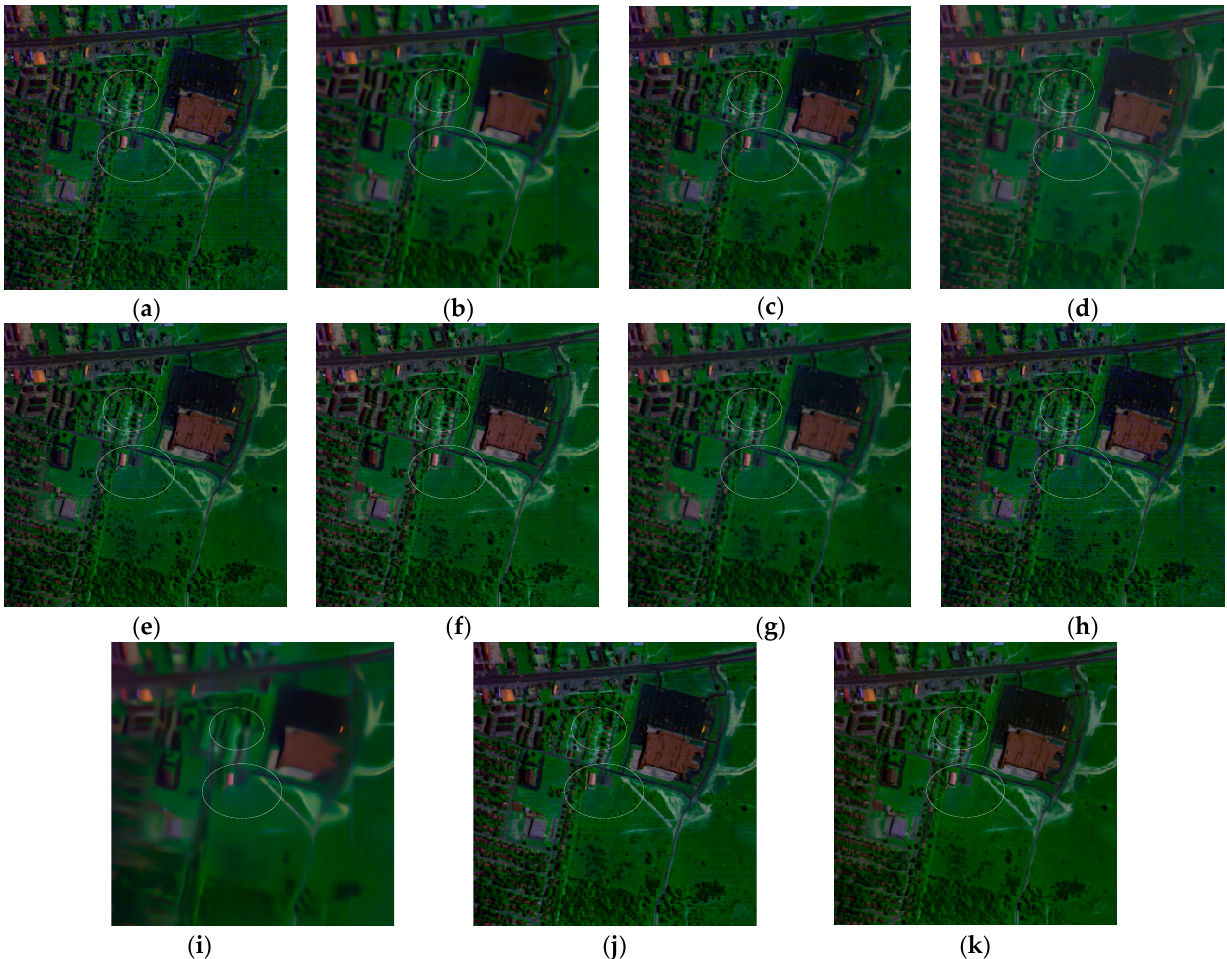
Figure 11. Restored results of the Urban image: ( a ) original pseudo-color image; ( b ) BM3D; ( c ) ANLM3D; ( d ) BM4D; ( e ) LRMR; ( f ) GLF; ( g ) LRTDTV; ( h ) LTDL; ( i ) DnCNN; ( j ) HSID-CNN; ( k ) VLRMFmcl. The white ovals are used to facilitate the comparison by marking the differences from the results obtained by different algorithms.